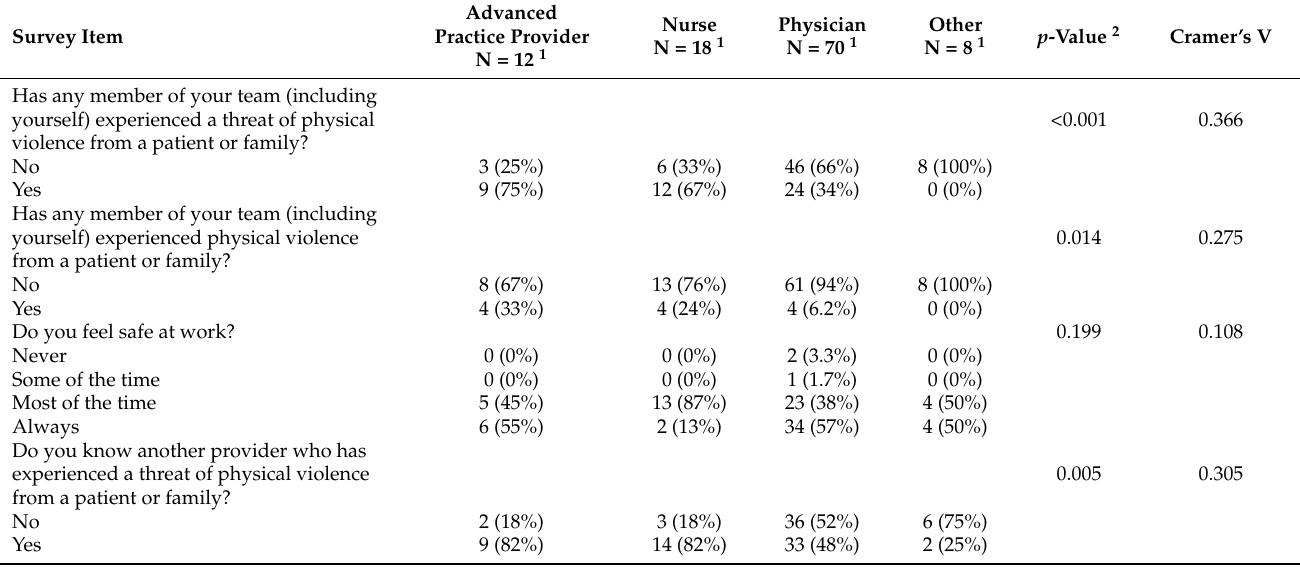
Table 5. Prevalence of Violence by Provider